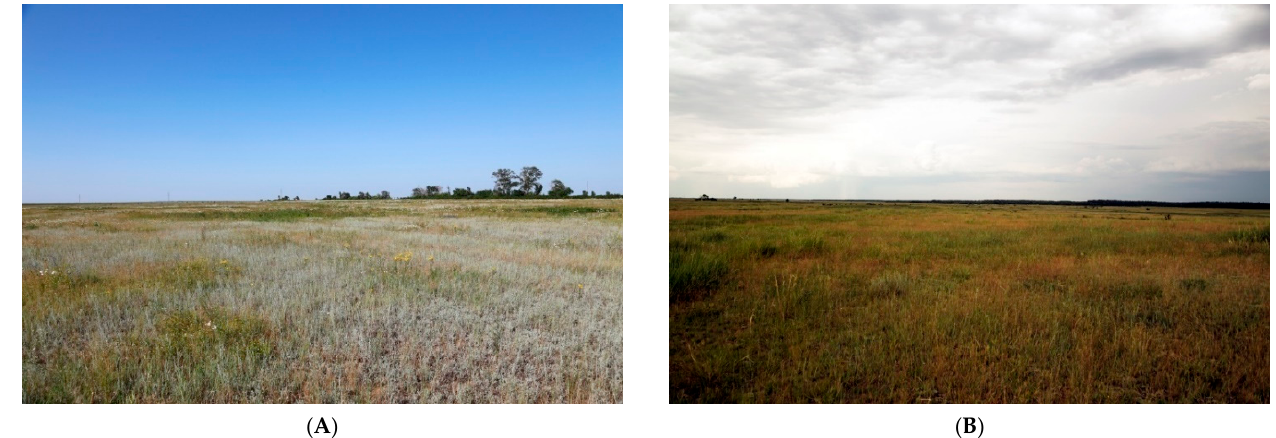
Figure 1. Typical habitats of the Italian locust in the Kulunda steppe: ( A )—northern steppe (near Aleksandrovskij settlement); ( B )—dry steppe (near Ust-Volchikha settlement).